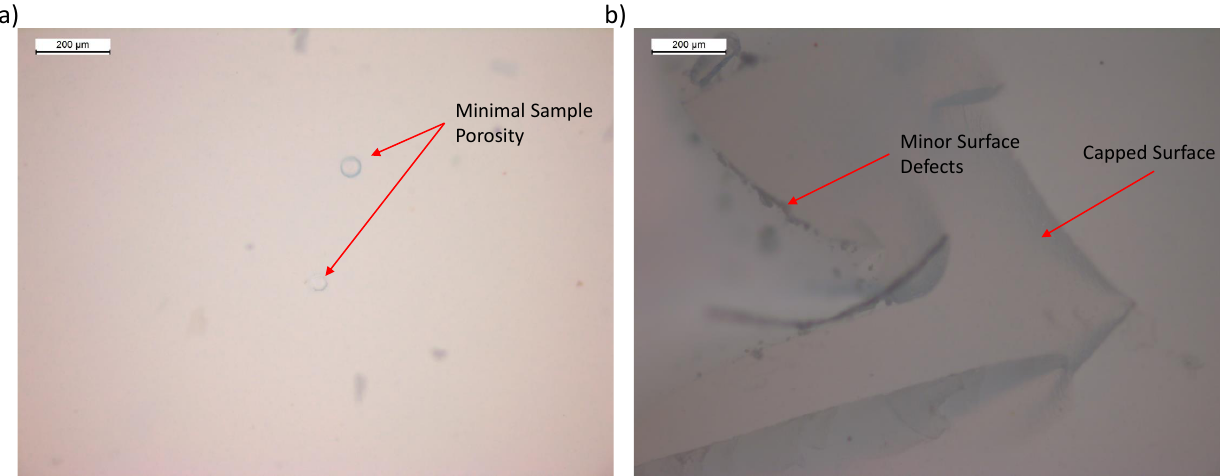
Figure A2. Microscope images of PTFE pellets showing minimal sample porosity and capping evidence on the surface of pellets compacted at lower pressures. ( a ) PTFE pellet produced with a compaction pressure of 392 MPa with minimal sample porosity and ( b ) PTFE pellet produced with a compaction pressure of 235 MPa with surface imperfections/capping.